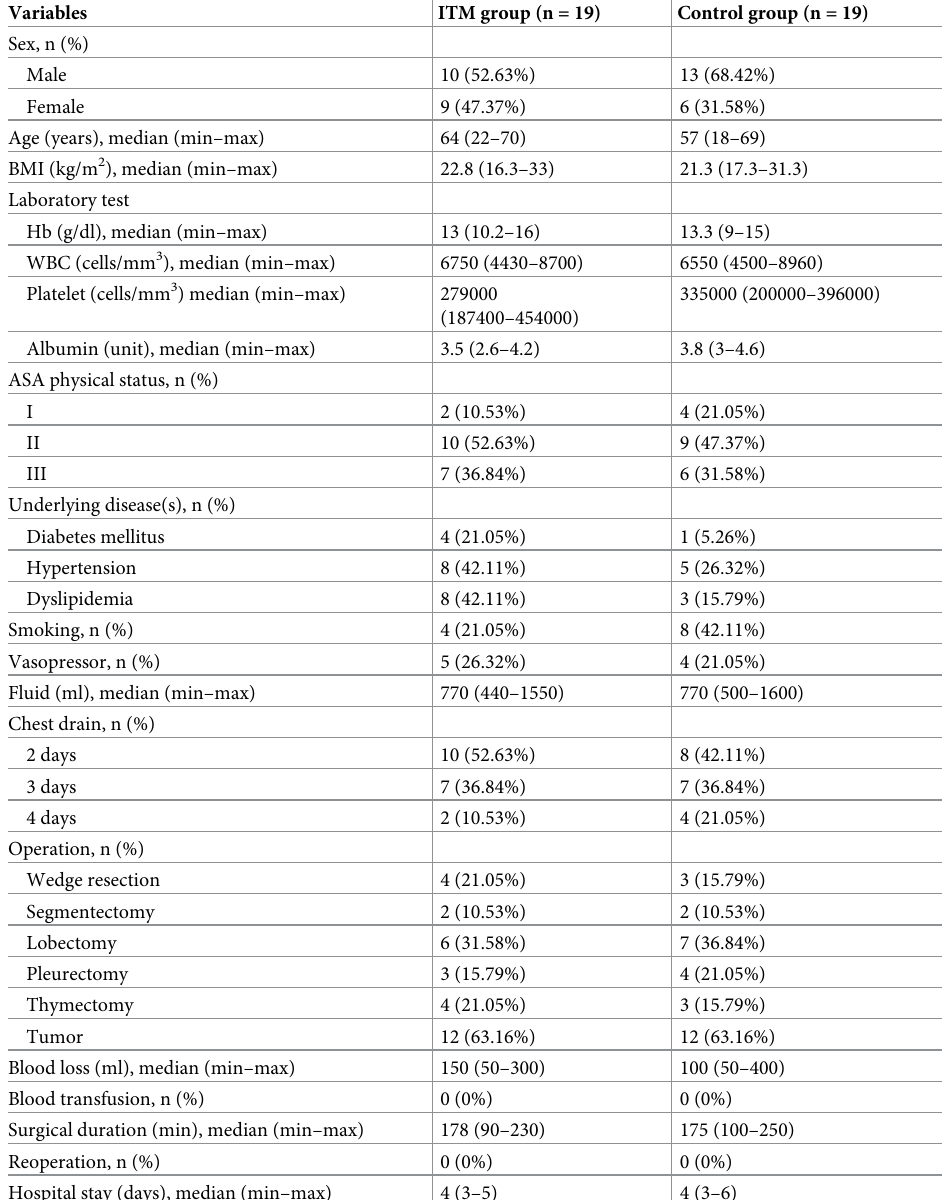
Table 1. Pre-operative demographics and characteristics.